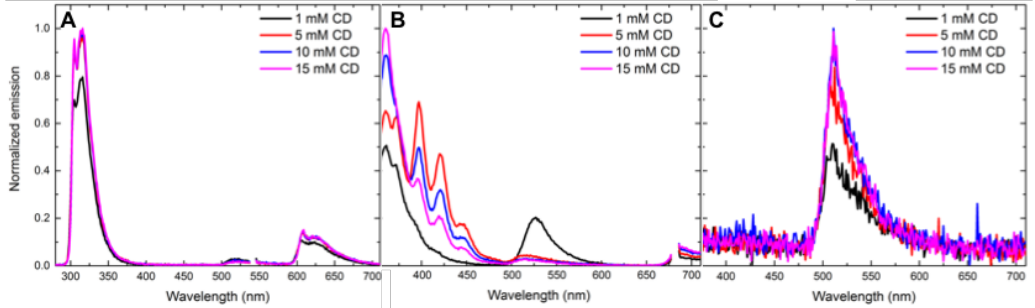
Figure 2. A comparison of the fluorescence emission obtained using 1 mM (black line), 5 mM (red (red line), 10 mM (blue line) and 15 mM (purple line) γ -cyclodextrin for ( A ) analyte 3 ; ( B ) analyte 4 ; line), 10 mM (blue line) and 15 mM (purple line) γ-cyclodextrin for ( A ) analyte 3 ; ( B ) analyte 4 ; and and ( C ) analyte 5 with fluorophore 7 ( C ) analyte 5 with fluorophore 7 . Table 1. Selected energy-transfer results for concentration-dependent energy-transfer experiments with fluorophore 7 as an acceptor. Control ratios are shown in parentheses a .